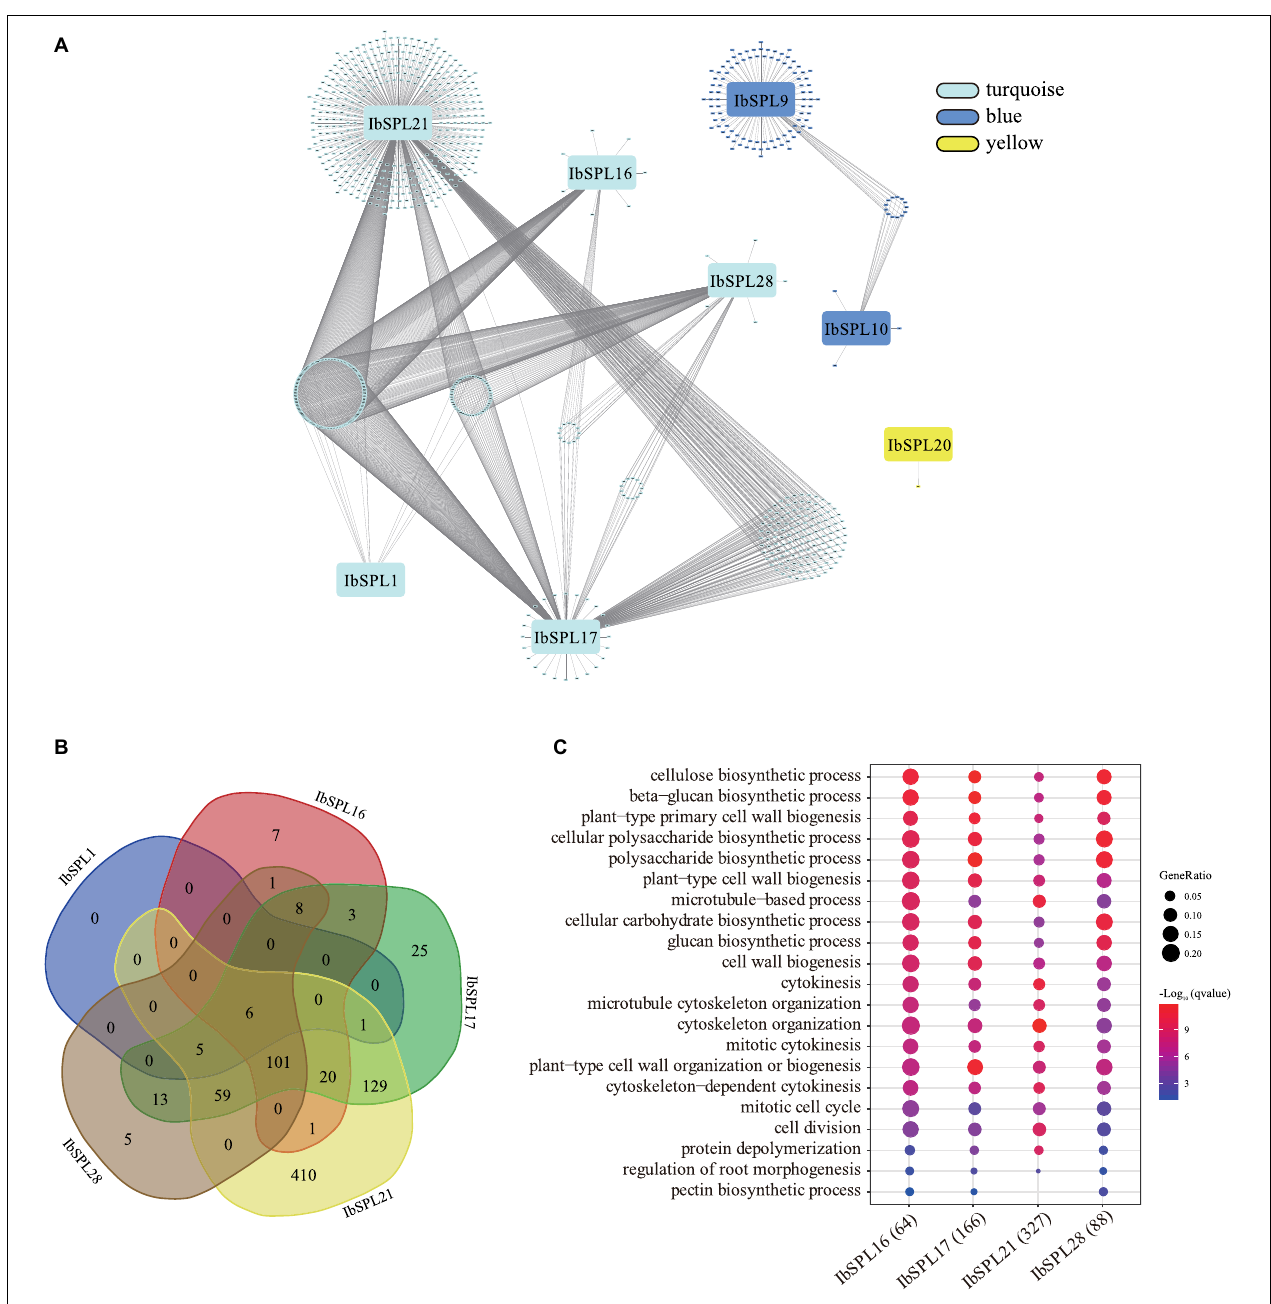
FIGURE 8 | Regulatory sub-networks involving IbSPLs and other I. batatas genes in the storage root of sweet potato. (A) Co-expression sub-network visualization for IbSPLs in the storage root of sweet potato. Only the edges with a weight above a threshold of 0.05 are displayed. (B) Venn diagram of the number of co-expressed genes for IbSPL1 , IbSPL16, IbSPL17 , IbSPL21 , and IbSPL28 in the turquoise module. (C) GO enrichment analysis of co-expressed genes for IbSPL16 , IbSPL17 , IbSPL21 , and IbSPL28 .